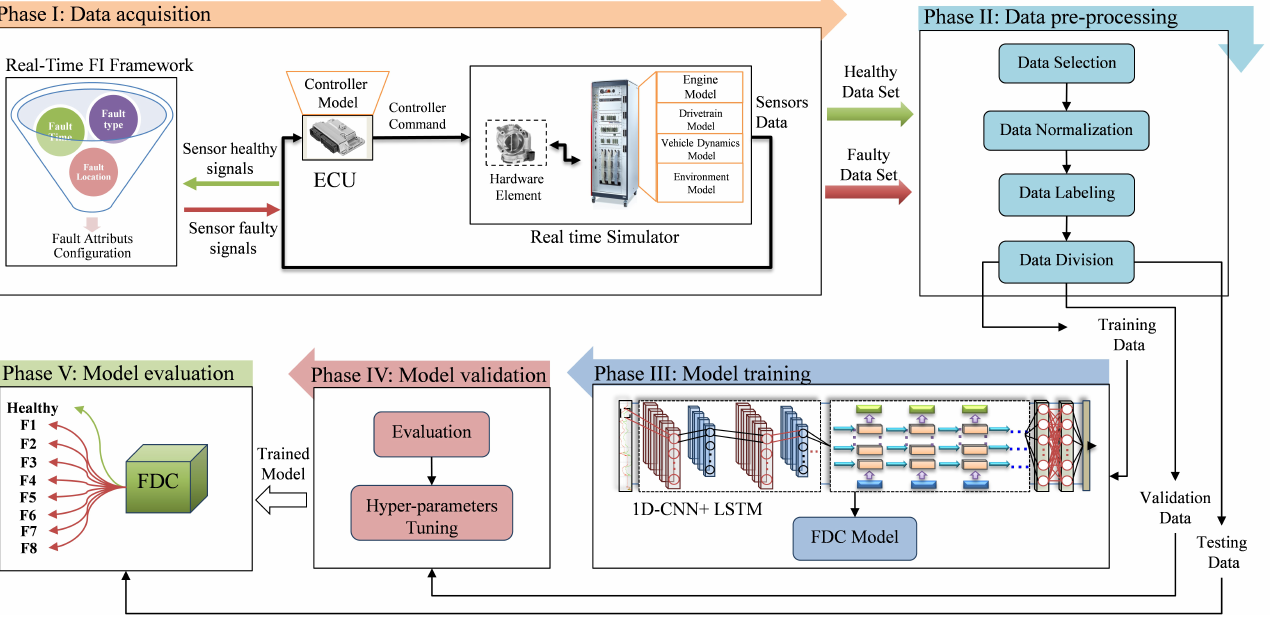
Figure 4. Hybrid DL-based FDC